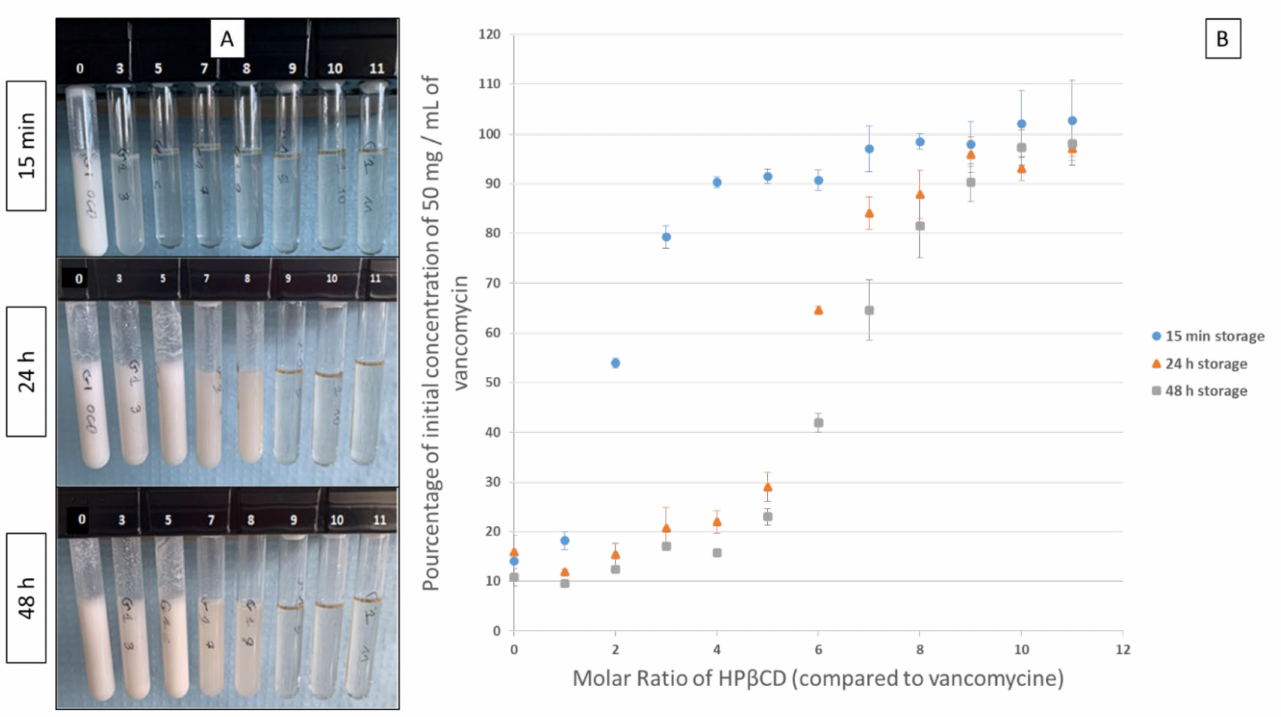
Figure 4. Influence of hydroxypropyl- β -cyclodextrins (HP β CD)/vancomycin molar ratio on vancomycin inclusion and precipitation at pH 8 as function of the HP β CD/vancomycin molar ratio immediately after preparation and after up to 48 h hours of storage: ( A ) visual aspect (the white numbers indicate the HP β CD/vancomycin molar ratio of the solutions and ( B ) vancomycin concentration ( n = 3, mean ± standard deviation). h = hour.